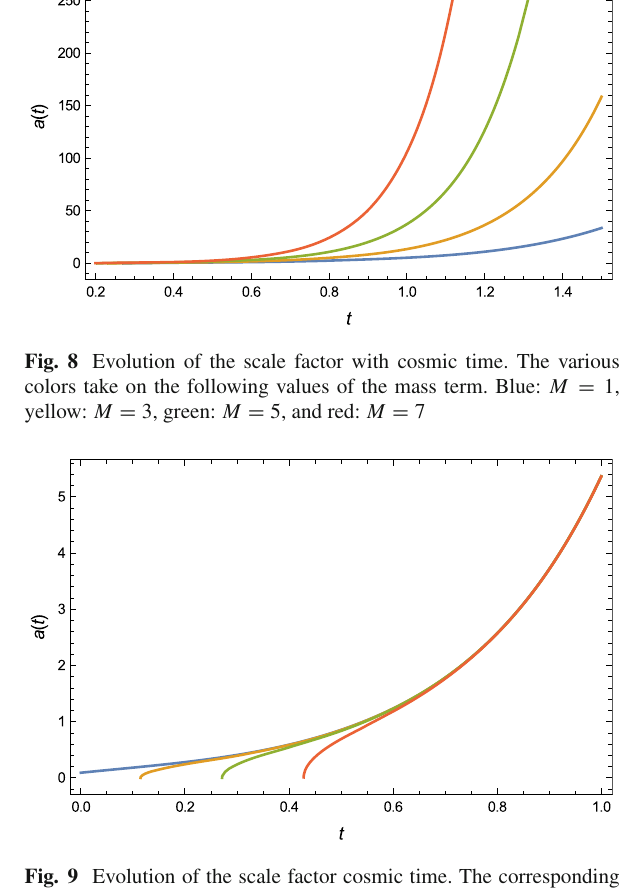
Fig. 9 Evolution of the scale factor cosmic time. The corresponding values of the λ term are as follows. Blue: λ = − 20, yellow: λ = − 10, green: λ = − 0 . 1, red: λ = 0 . 1, and violet: λ = 1. The mass term is